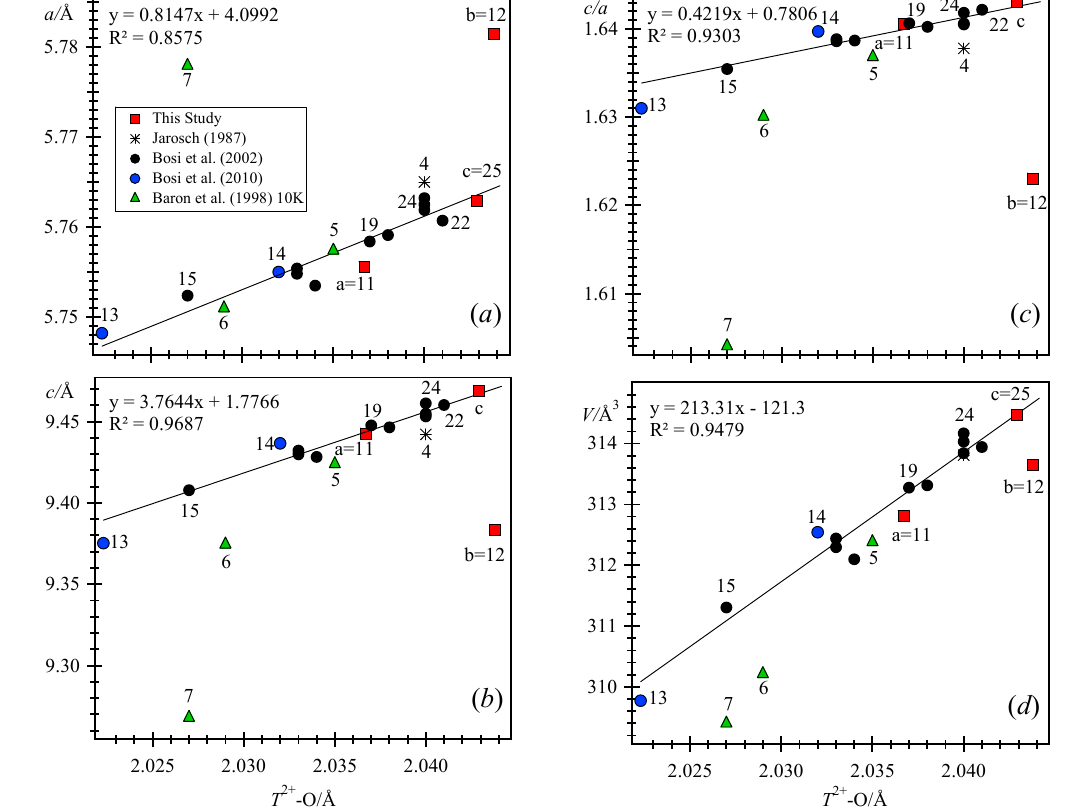
Figure 4. Structural variations for hausmannite solid solutions (data from Table 1). The average < T –O > distances vary linearly with unit-cell parameters: ( a ) a , ( b ) c , ( c ) c / a ratio, and ( d ) V . Samples-a and -c fall close to the trend lines, but samples-b and -7 are off the trend lines. Sample-b has the largest T –O distance. Of the samples close to the trend lines, samples-c has the largest T –O distance, whereas the Mg-rich sample-13 has the smallest T –O distance.